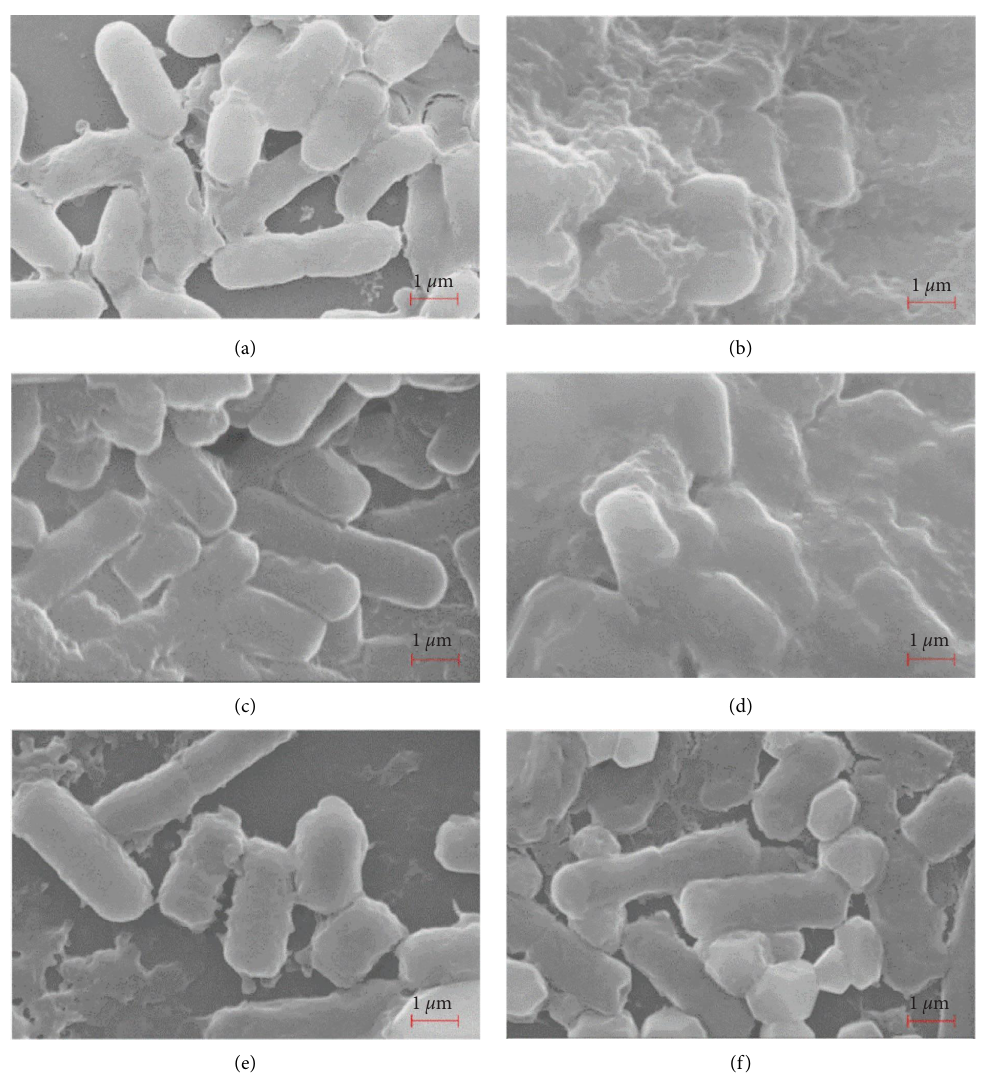
Figure 2: Te scanning electron micrographs of (a) control (untreated) LM cells, (b) LM cells treated with sTac-I, (c) LM cells treated with sTac-II, (d) LM cells treated with sTac-III, (e) LM cells treated with CDT, and (f) LM cells treated with